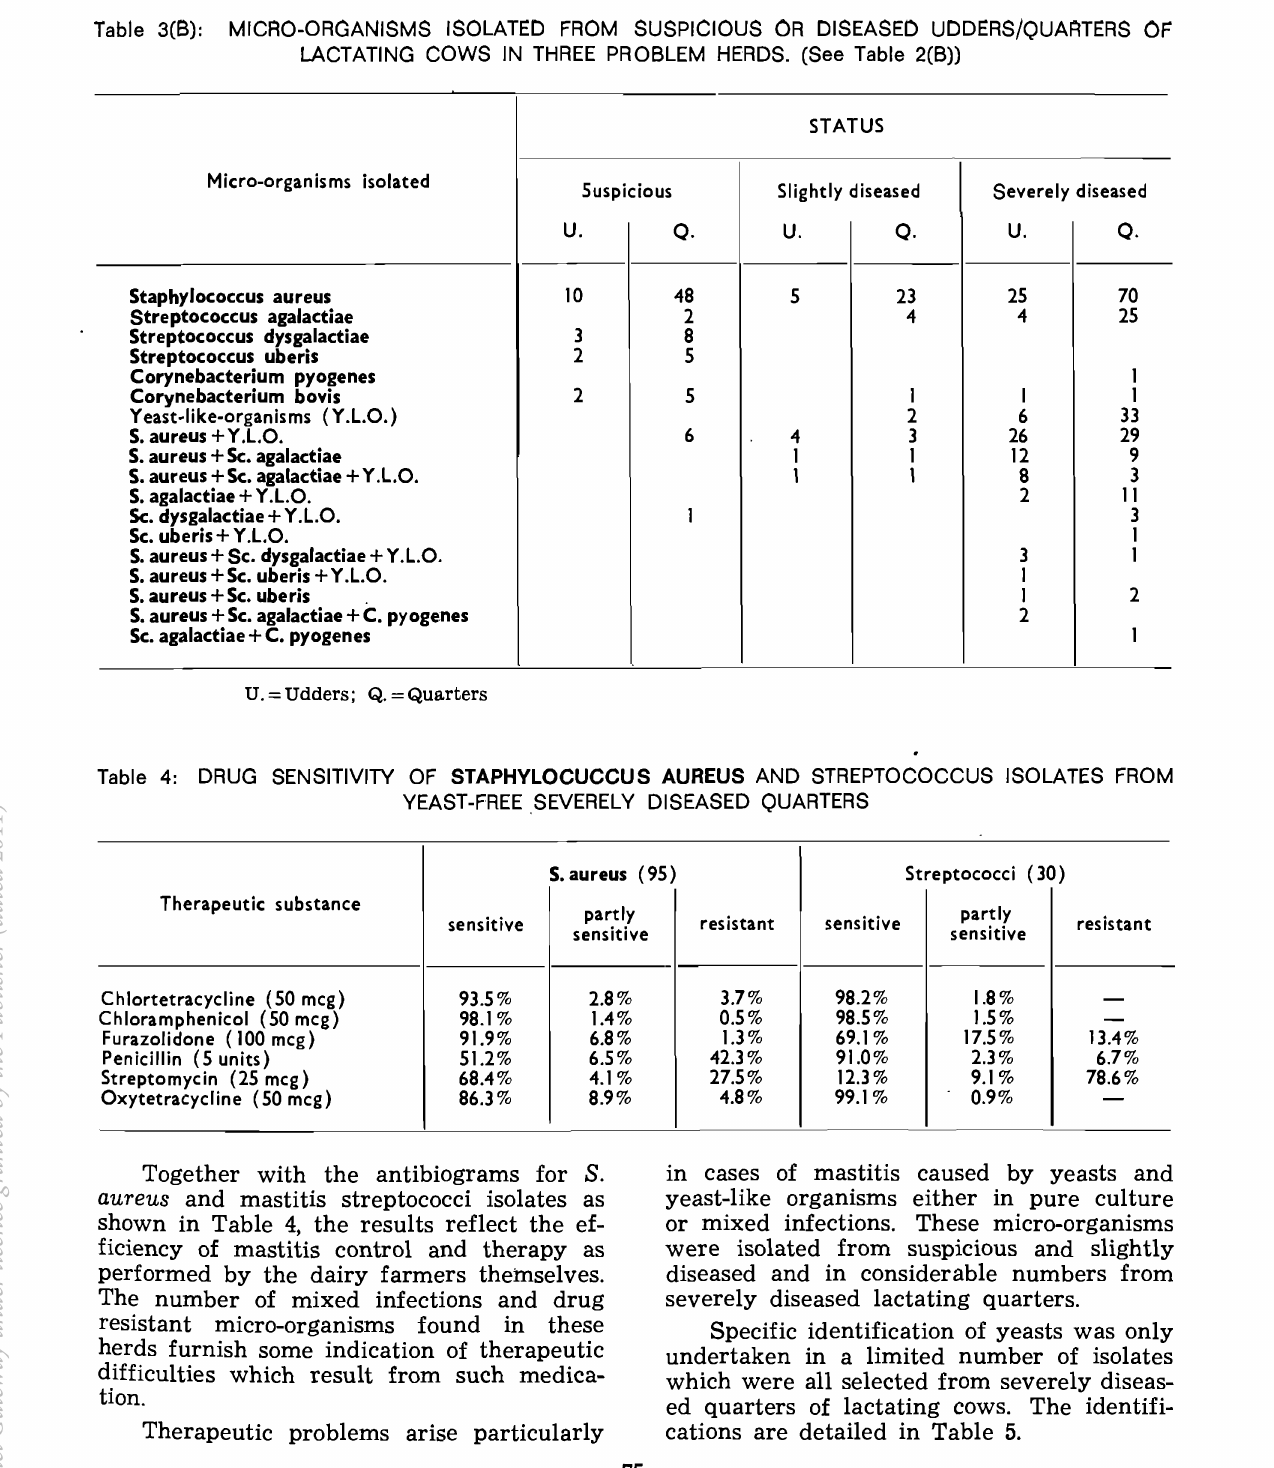
Table 3(B): MICRO-ORGANISMS ISOLATED FROM SUSPICIOUS OR DISEASED UDDERS/QUARTERS OF LACTATING COWS IN THREE PROBLEM HERDS. (See Table 2(B))